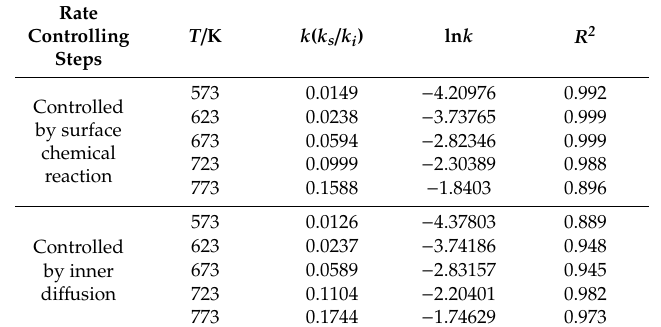
Table 4. Kinetic parameters of shrinking core model.